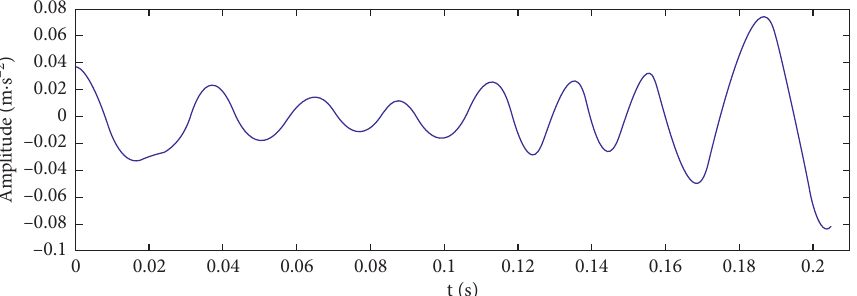
Figure 8: Time-domain waveform of sensitive IMF component by the EMD method.